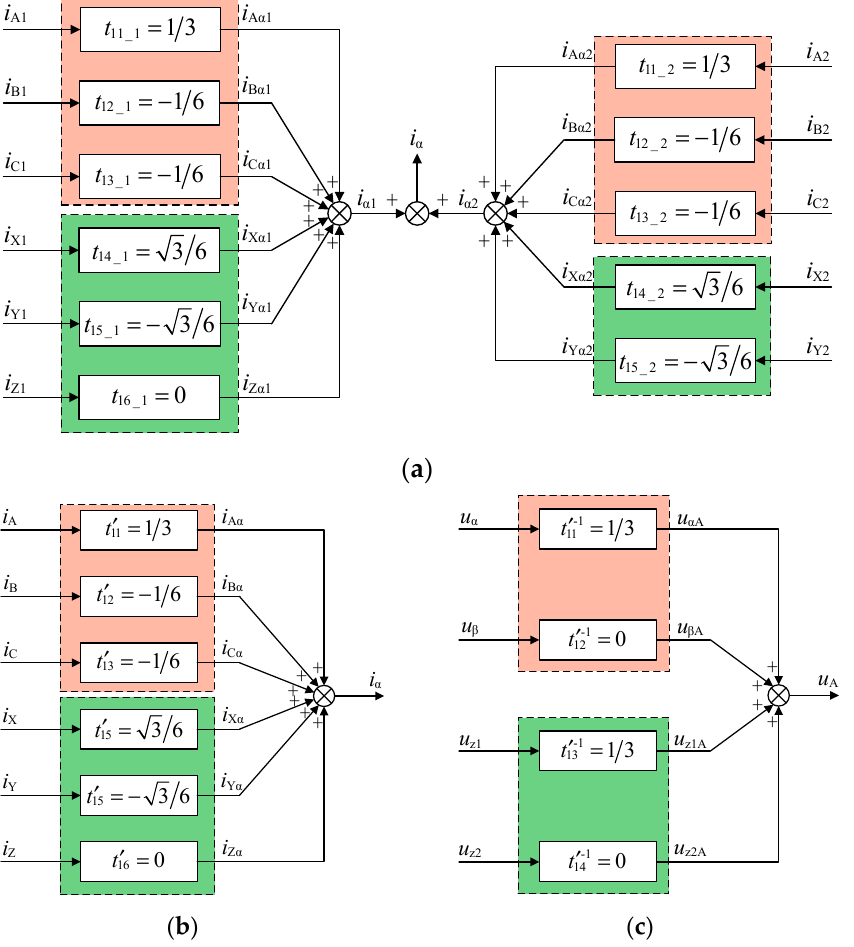
Figure 3. The block diagram of the three-subplane decomposition stationary transformation (take the transformation to obtain i α and u A as an example). ( a ) The transformation by T 6s and T 5s . ( b ) Three-subplane decomposition transformation. ( c ) Three-subplane decomposition inverse transfor- mation.